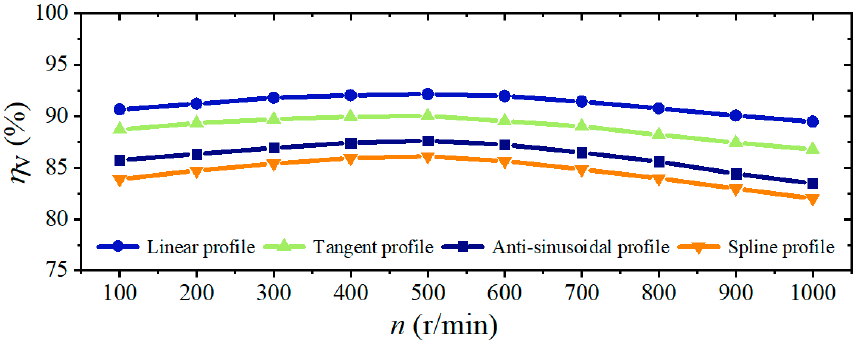
Figure 13. Relationship between VE and rotating speed.